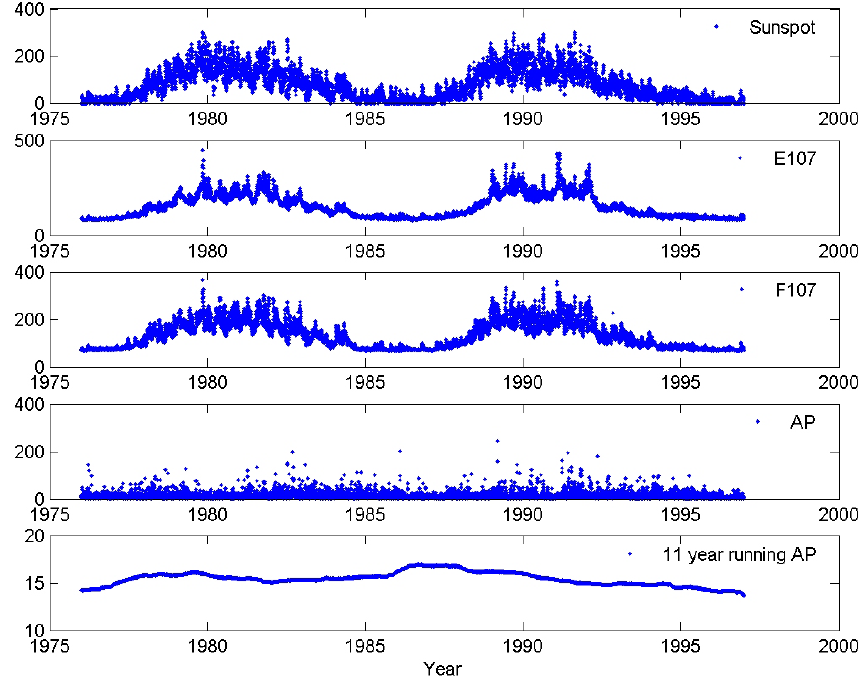
Fig. 1. Course of daily values of solar ( R , F10.7, E10.7) and geomagnetic activity ( A p ),